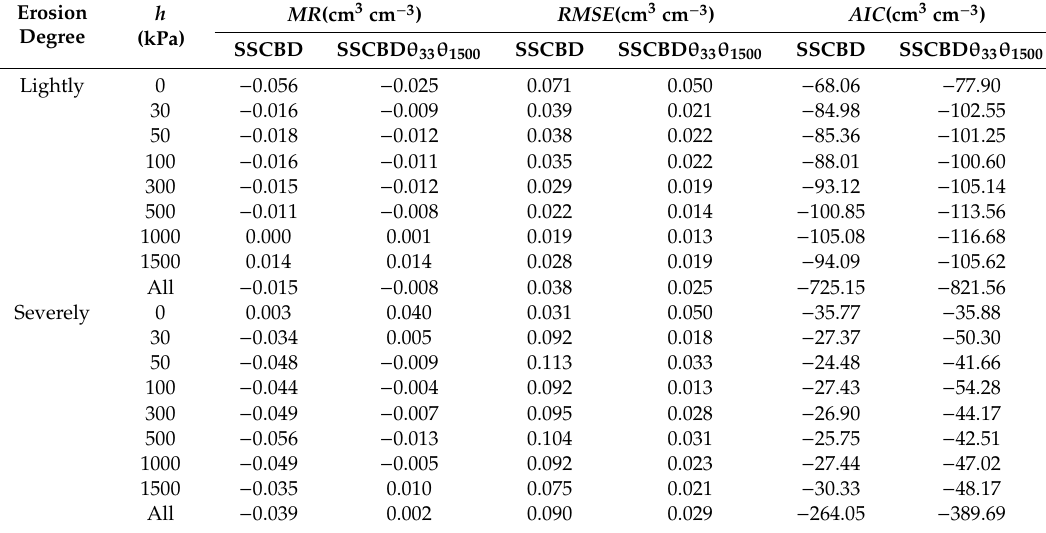
Table 8. MR , RMSE and AIC between simulated and measured soil water contents in model validation for the lightly and the severely eroded